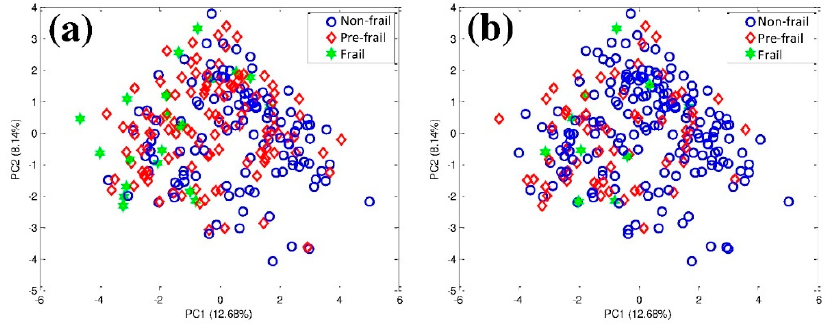
Figure 2. Principal component analysis (PCA) results of the ( a ) modified Fried’s Frailty Phenotype (mFFP), and ( b ) modified Frail Non-Disable (mFiND) questionnaire: ○ Non-frail,